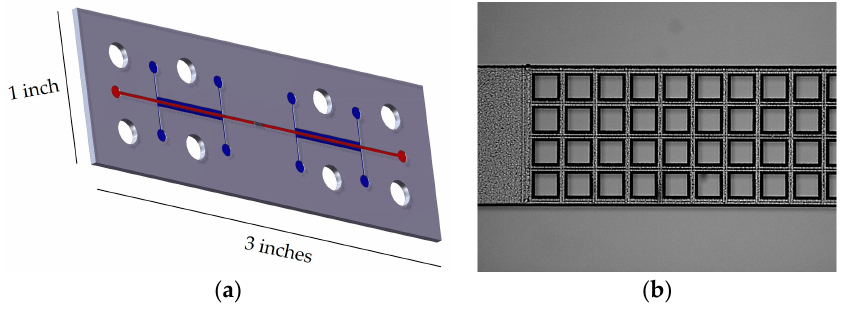
Figure 2. ( a ) Illustration of the fused silica microfluidic chip. Liquid electrodes and the sample channels are indicated by blue and red lines, respectively. The array of 4 by 15 square pillars act as insulating barriers in the middle of the sample channel. ( b ) Microscope image of the middle of the microfluidic sample channel showing the array of pillars in the middle of the sample channel. Pillar dimensions are 100 μ m by 100 μ m.